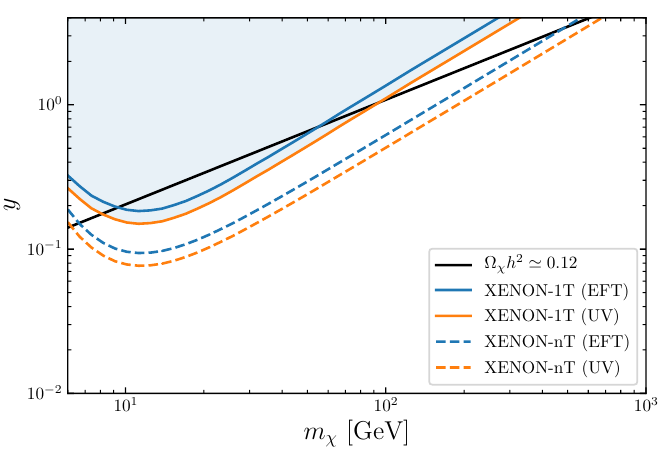
Figure 7 . Constraints on the UV complete model defined in eq. (3.15) for any charged lepton f and m φ = 2 m χ . EFT/UV indicates that the curve takes the loop-induced dipole in eq.